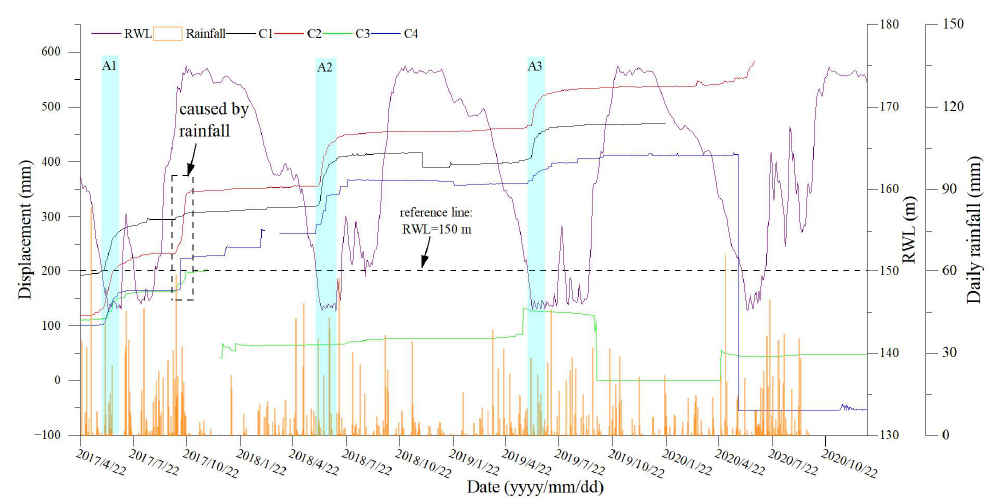
Figure 10. The displacement of crack meters C1, C2, C3, and C4.